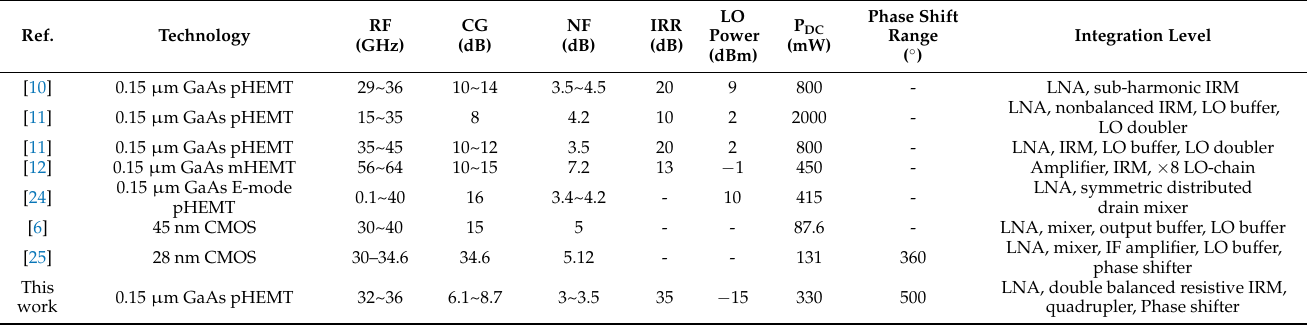
Table 1. Measured performance comparison of previously published receiver front-end